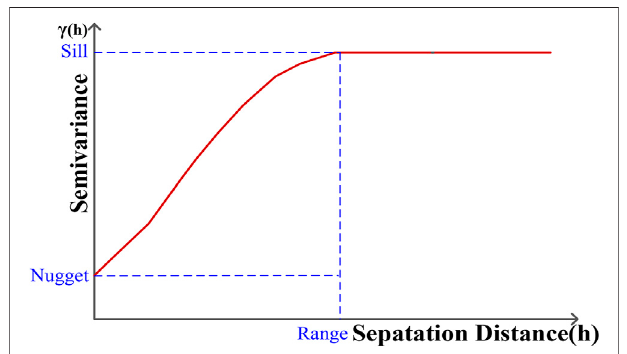
FIGURE 5 | Schematic curve of